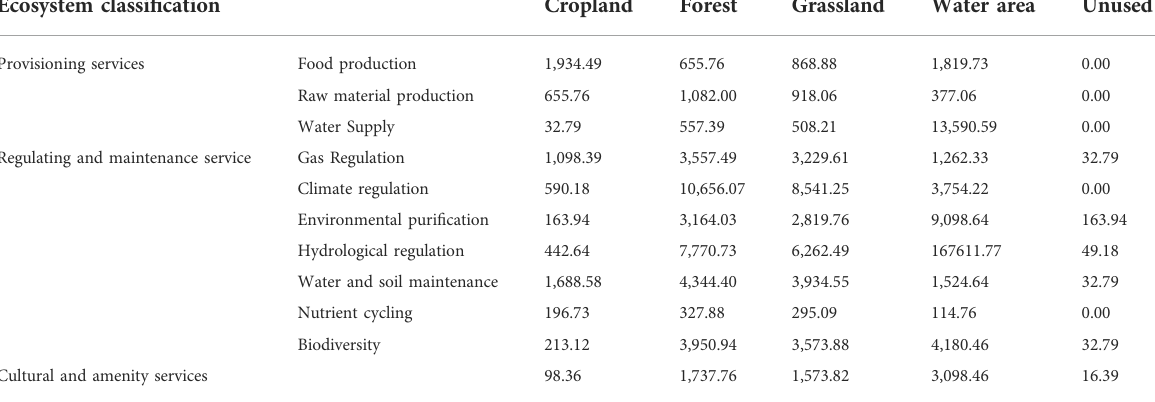
TABLE 1 ESV per unit area in Luoyang